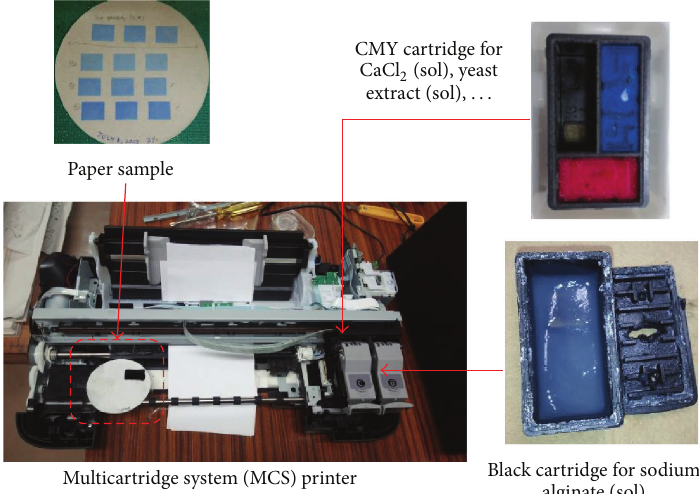
Figure 5: Processing of MCS printer and procedure of medium printing.